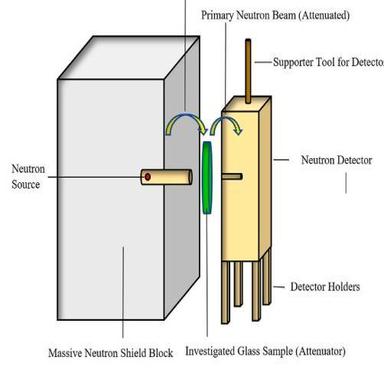
(a–b). Experimental setup for (a) gamma-ray and (b) neutron transmission measurements.